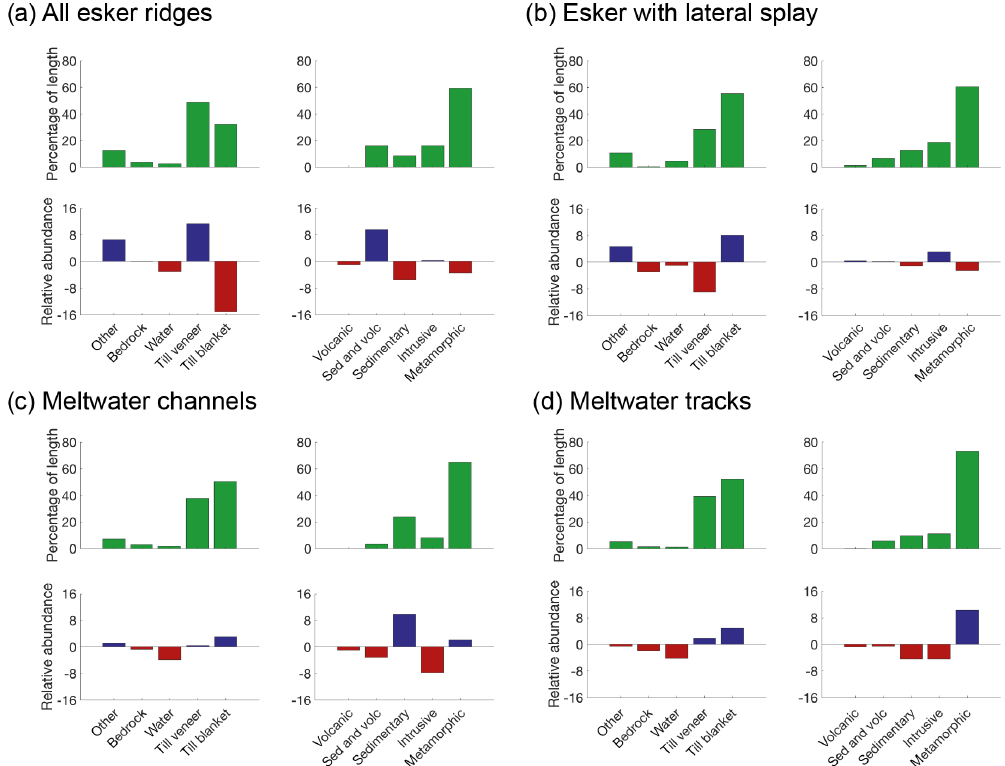
Figure 10. Substrate control on geomorphological expression. Occurrence (percentage of length) and relative abundance of different melt- water features over varying surface substrates (Fulton, 1995) and background geology (Wheeler et al., 1996). “Other” includes marine, lacustrine and glaciofluvial sediments. Blue represents over representation and red represents under